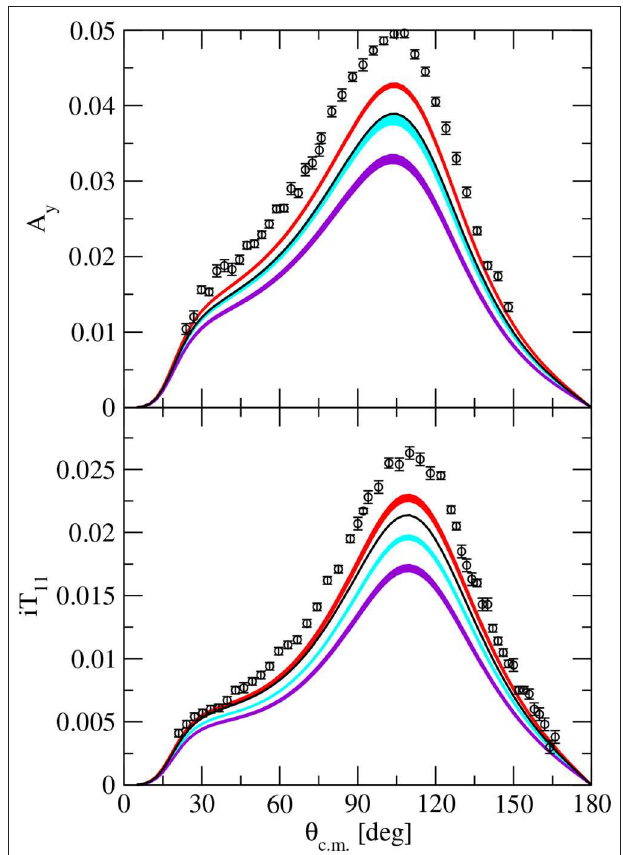
FIGURE 1 | The vector analyzing powers A y and iT 11 for p − d elastic scattering at center-of-mass energy E c . m . = 2 MeV, using models in the AV18/TM class (cyan bands), AV18/UIX (violet bands), and AV18/N2LO (red bands). The predictions of the original AV18/UIX model (solid lines) and the experimental points from reference [86] are also